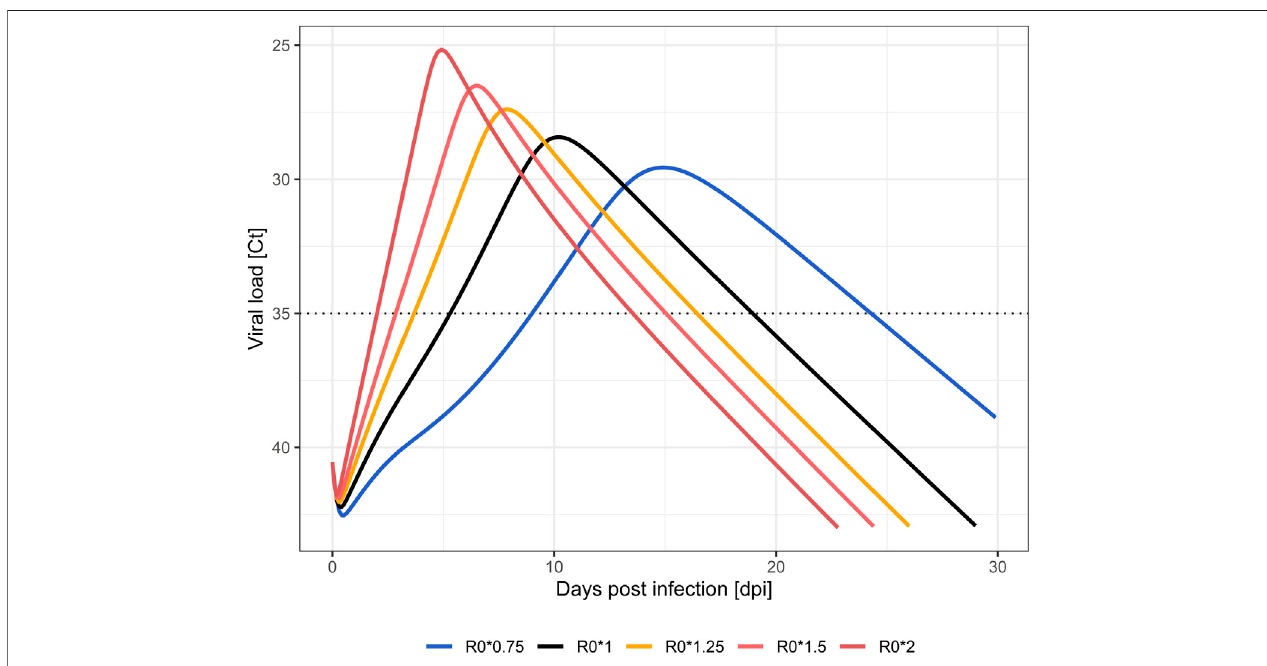
FIGURE1| Simulatedviral loadpro fi les bychange inwithin-hostinfectivity (R 0 ).Wild type SARS-CoV-2strain (black), less transmissible(blue), highly transmissible (orange to red) variants. Limit of quanti fi cation (Ct = 35) is displayed as a dotted line.